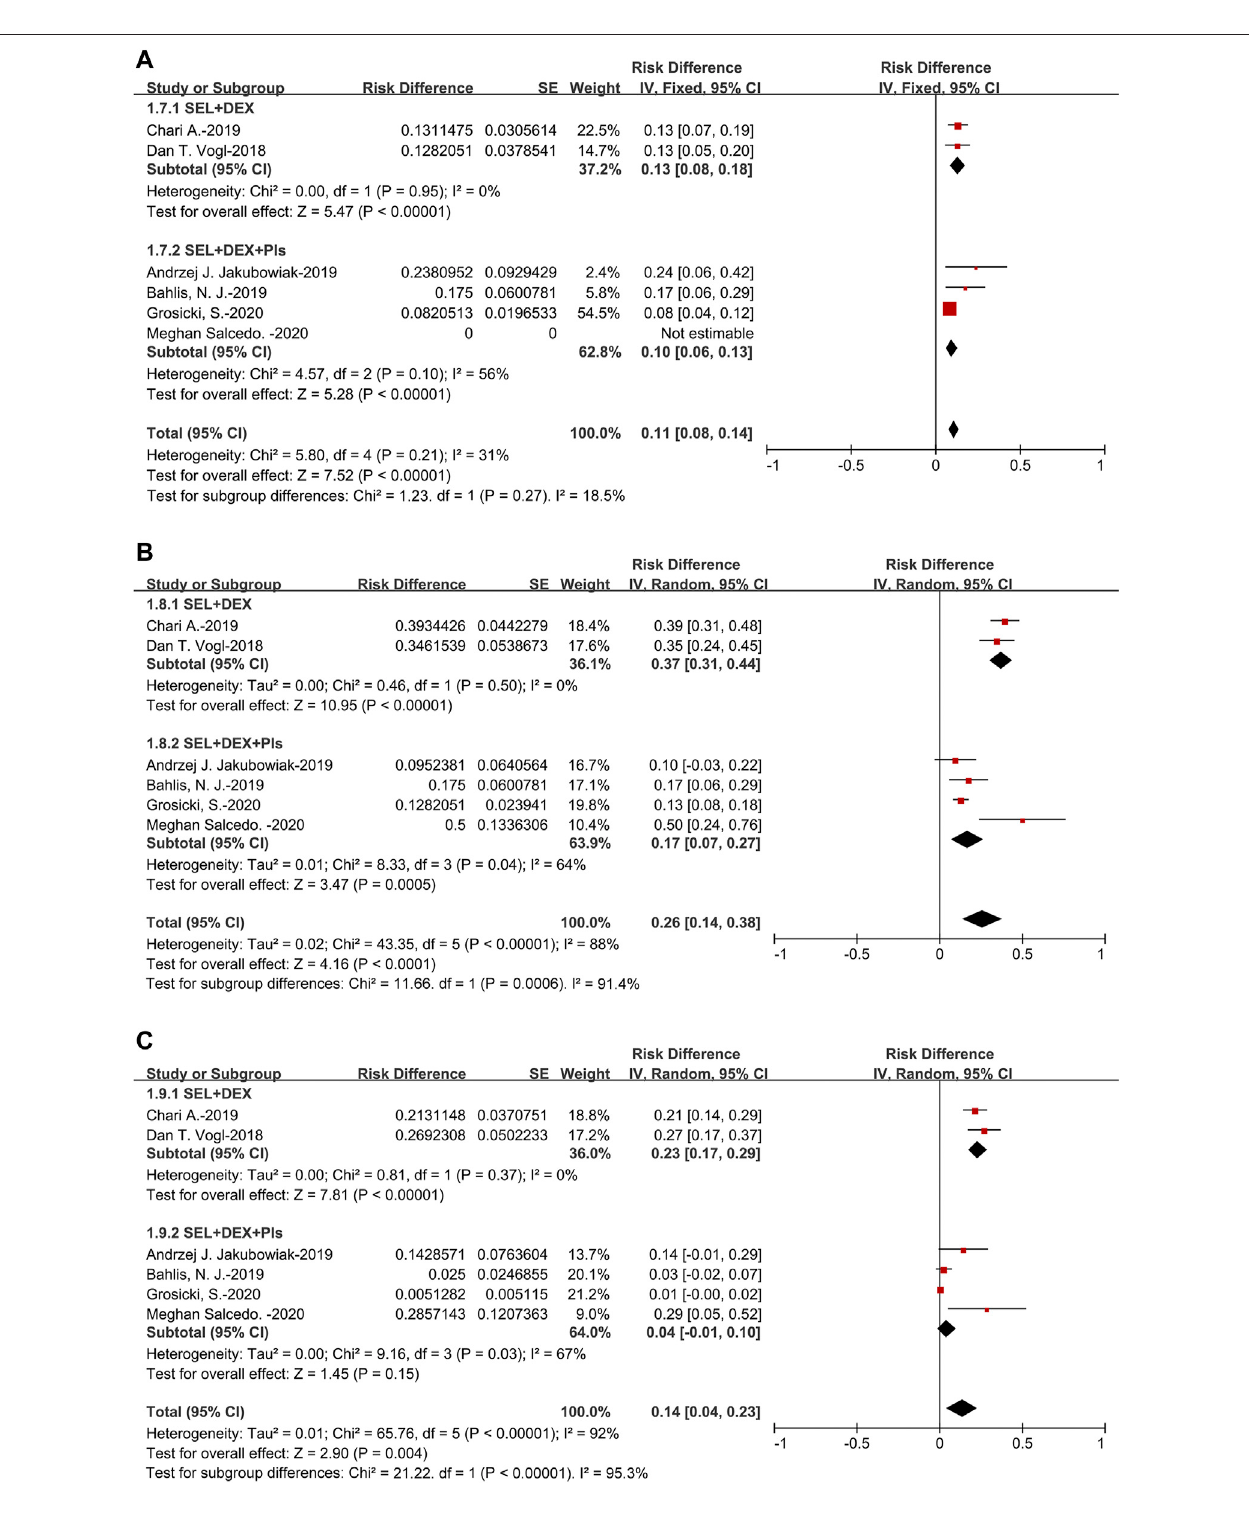
FIGURE 5 | The forest plot of pooled (A) MR (B) SDR, and (C) PDR.